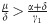
The way I
1 and I
2 vary with the increasing β
1, provided μδ>α+δγ1.